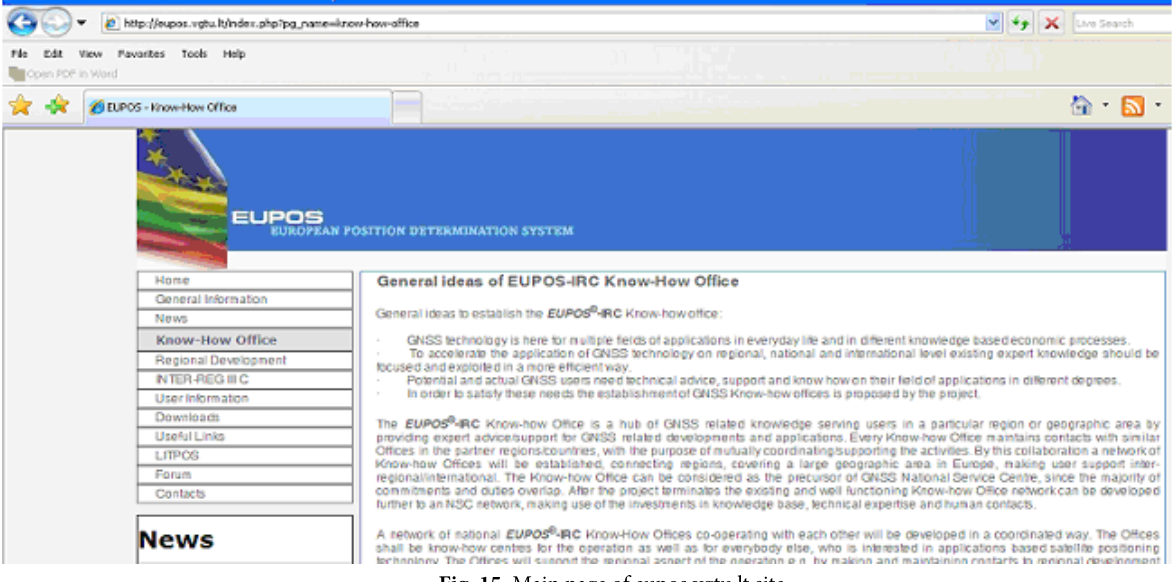
Fig. 15. Main page of eupos.vgtu.lt